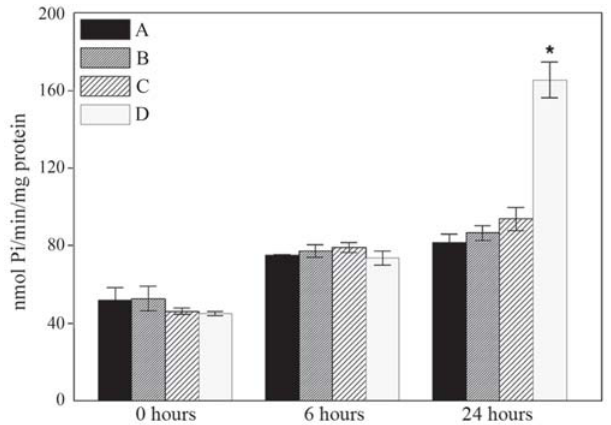
Fig. 2. ADP hydrolysis in supernatant of whole brain of silver catfish.